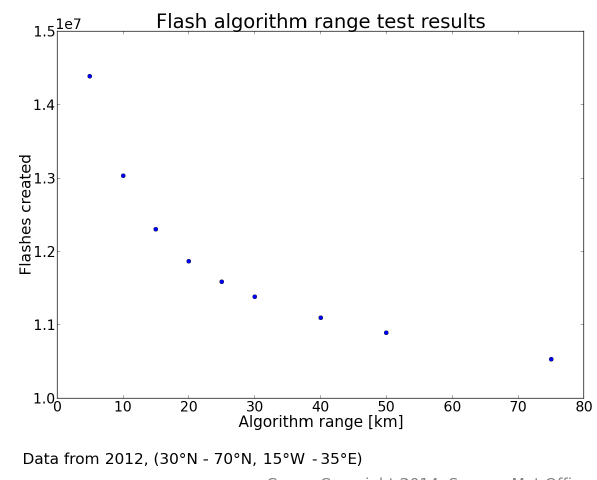
Fig. 3. Flashes created using different correlation ranges for group- ing fixes using data from 2012. A maximum flash duration was set at